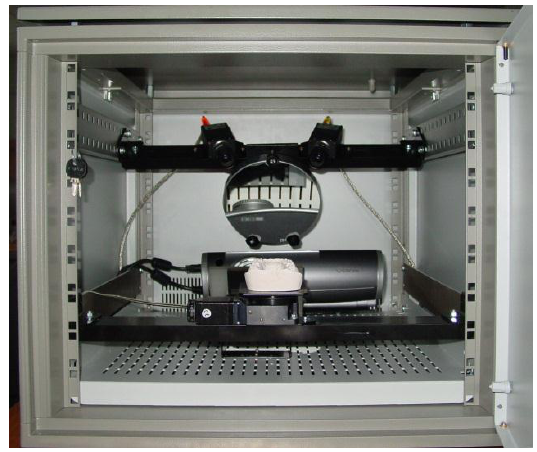
Figure 3. Photogrammetric system for 3D reconstruction of dental